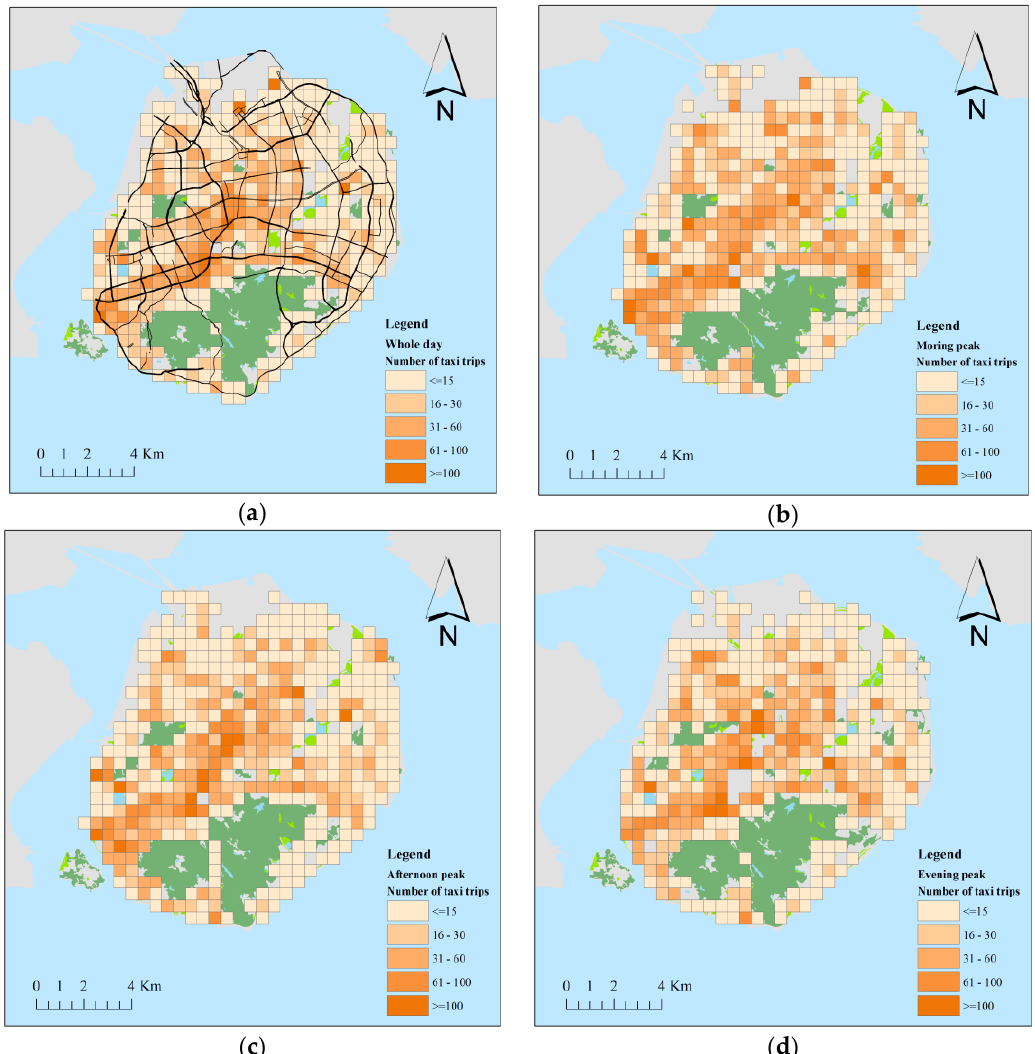
Figure 4. Spatial distribution of taxi ridership at different periods. ( a ) Whole day; ( b ) morning peak; ( c ) afternoon peak; and ( d ) evening peak.